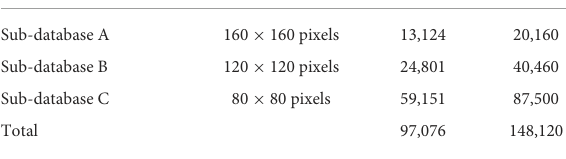
TABLE 1 Dataset scale of